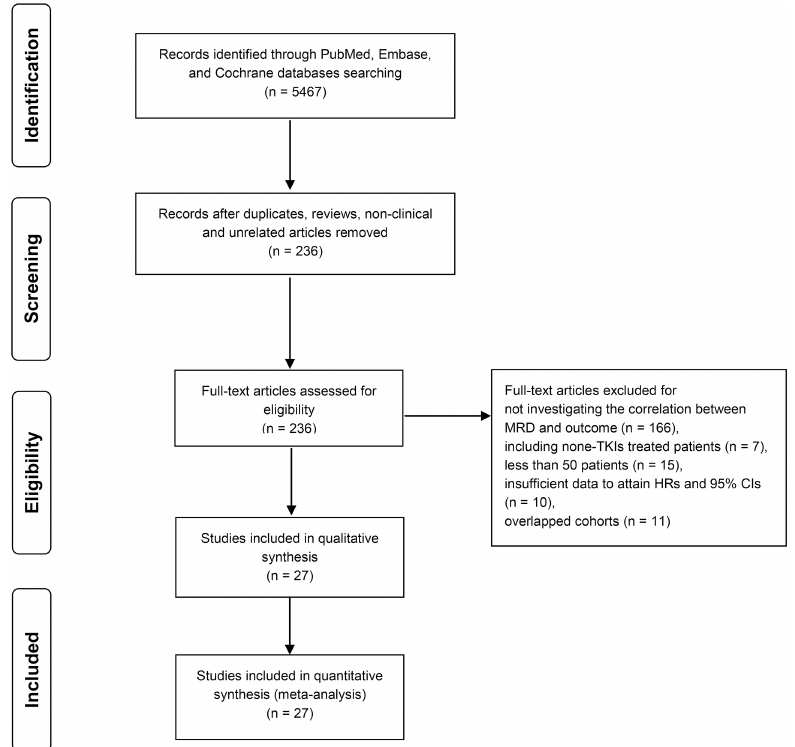
Fig 1. PRISMA flow diagram for study review and